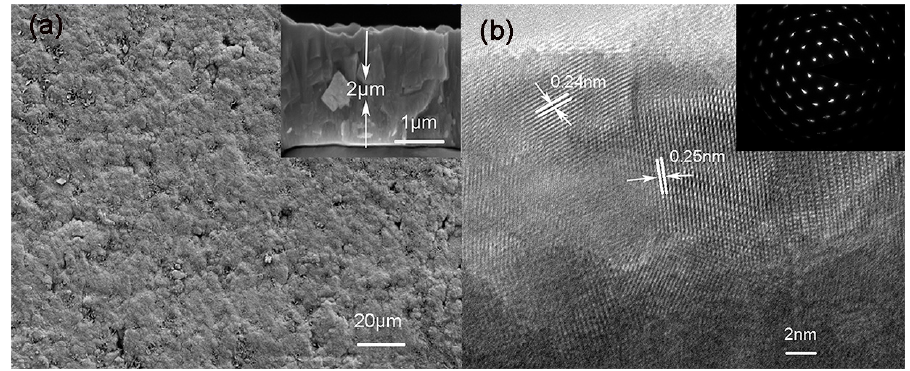
Figure 3. ( a ) SEM images of ZnO film; and ( b ) HRTEM and SAED images of ZnO film.